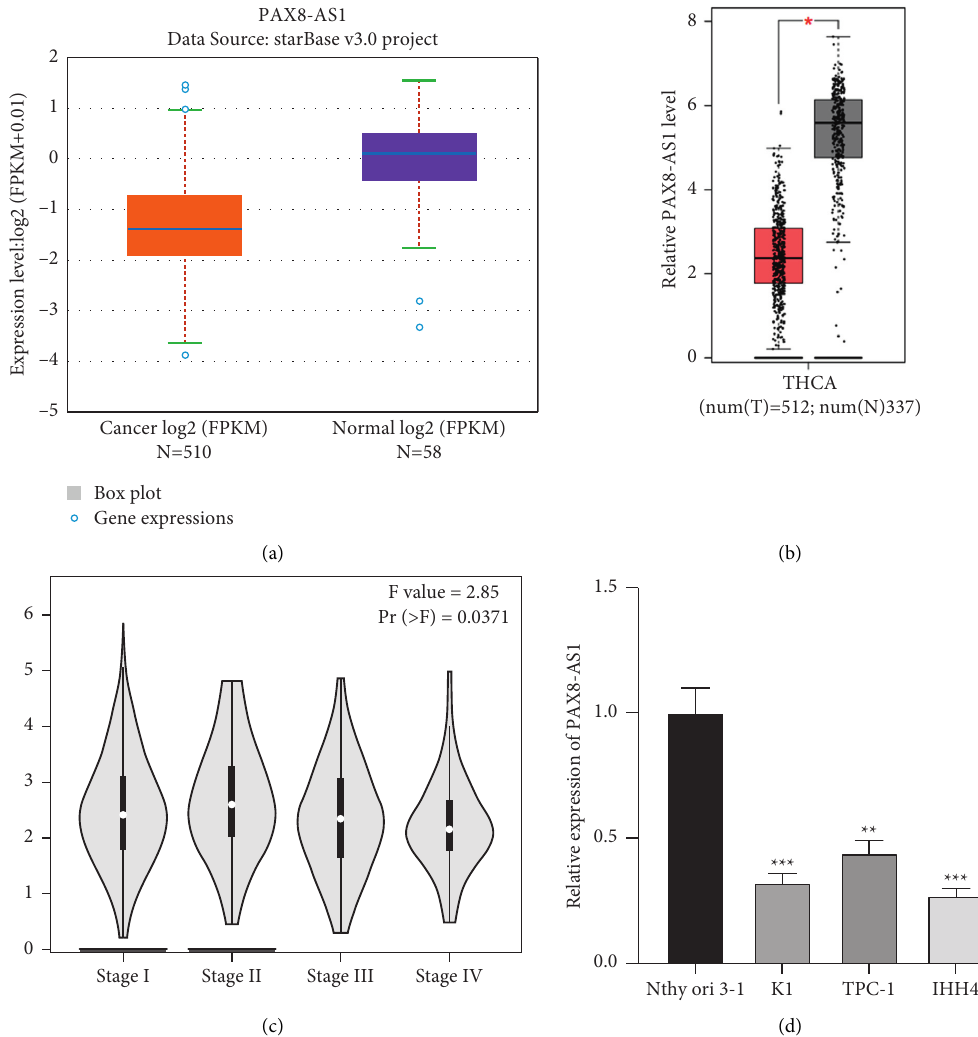
Figure 1: Low expressed lncRNA PAX8-AS1 in PTC tissues and cells. Note. (a) ENCORI website (http://starbase.sysu.edu.cn/) showed the expression of PAX8-AS1 in THCA tissues ( n � 510) and normal tissues ( n � 58); (b) GEPIA website (http://gepia2.cancer-pku.cn/) showed the expression levels of PAX8-AS1 in THCA tissues ( n � 512) and normal tissues ( n � 337); (c) GEPIA website showed the expression level of PAX8-AS1 in different stages of THCA patients; (d) the expression of PAX8-AS1 in PTC cell lines (K1, TPC-1, and IHH4) and human normal thyroid Nthy-ori 3-1 cells. ∗ P < 0 . 05 , ∗∗ P < 0 . 01 , and ∗∗∗ P < 0 .